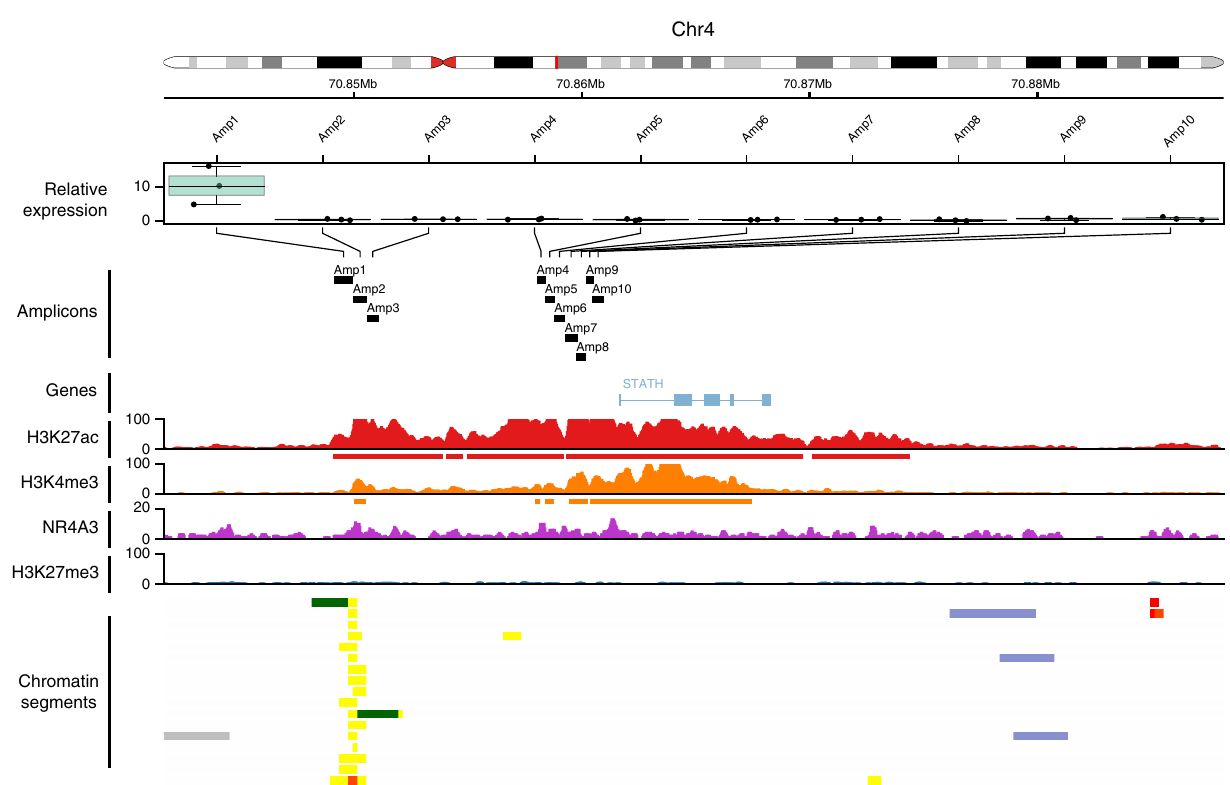
Fig. 5 Analysis of enhancer activity in a genomic region shared by AciCCs with t(4;9)(q13;q31) rearrangement. Correlation of enhancer activity determined in the dual luciferase reporter assay for ten different genomic fragments (upper panel) with chromatin marks determined by ChIP-seq analyzes in parotid salivary gland tissue (middle panel) and putative enhancer regions based on genome wide chromatin segmentation (lower panel) (11) . For each fragment, relative expression values for three replicates normalized to the control vector are presented. Box-plot center line: median; bounds of box: 25 and 75% quantiles; whiskers: minimum and maximum values). One-tailed Student ’ s t -test; Amplicon 1: P < 0.001. Source data are provided as a Source Data fi